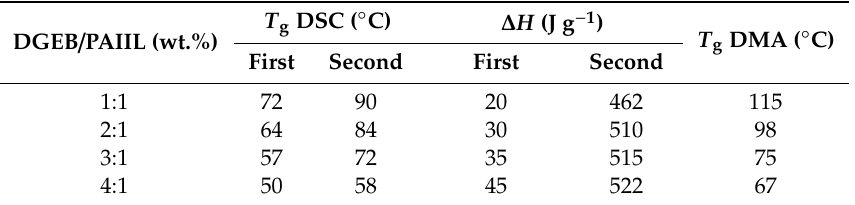
Table 1. DSC and DMA data of DGEB / PAIIL.